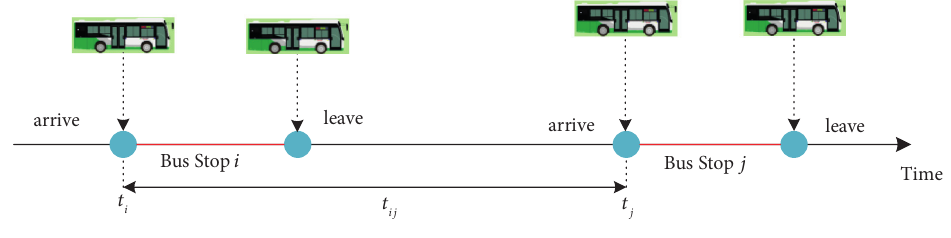
Figure 3: Illustration of IVT.